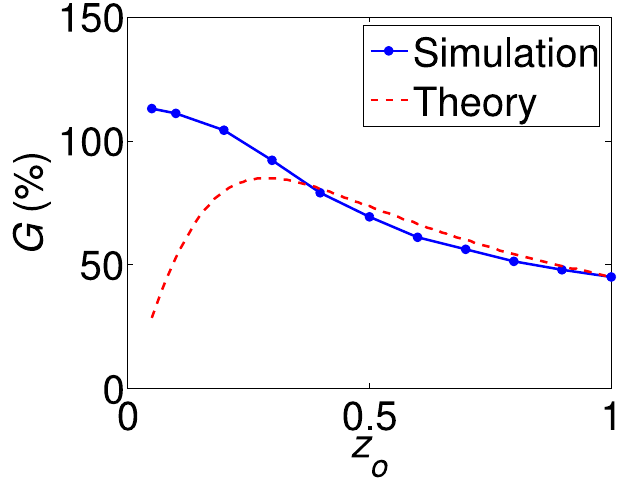
FIG. 5. (Color) Simulation results for FEL weak-field gain as a (solid blue line). The function of normalized Rayleigh length z 0 results are compared to a simple theory (dashed red line), which assumes the optical field is in the fundamental mode. The large disagreement between the simple theory and simulations for is due to mode small z 0